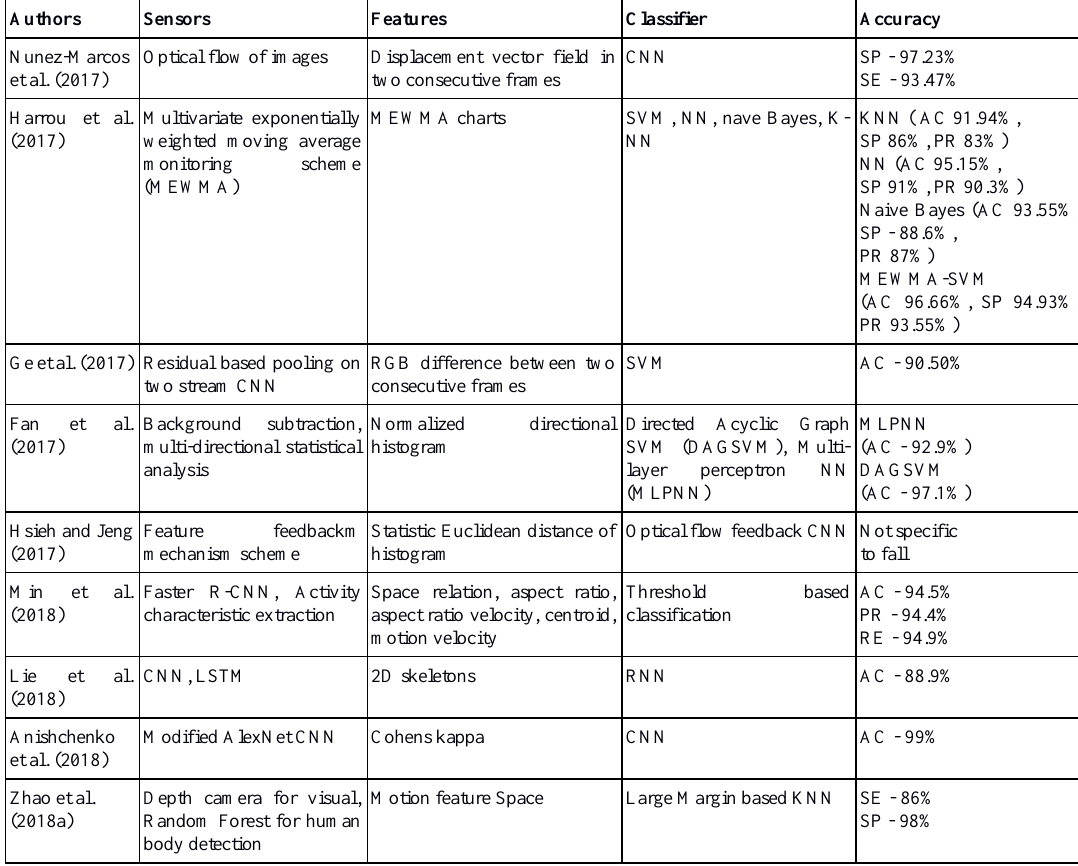
Table 6. Vision-based fall detection systems